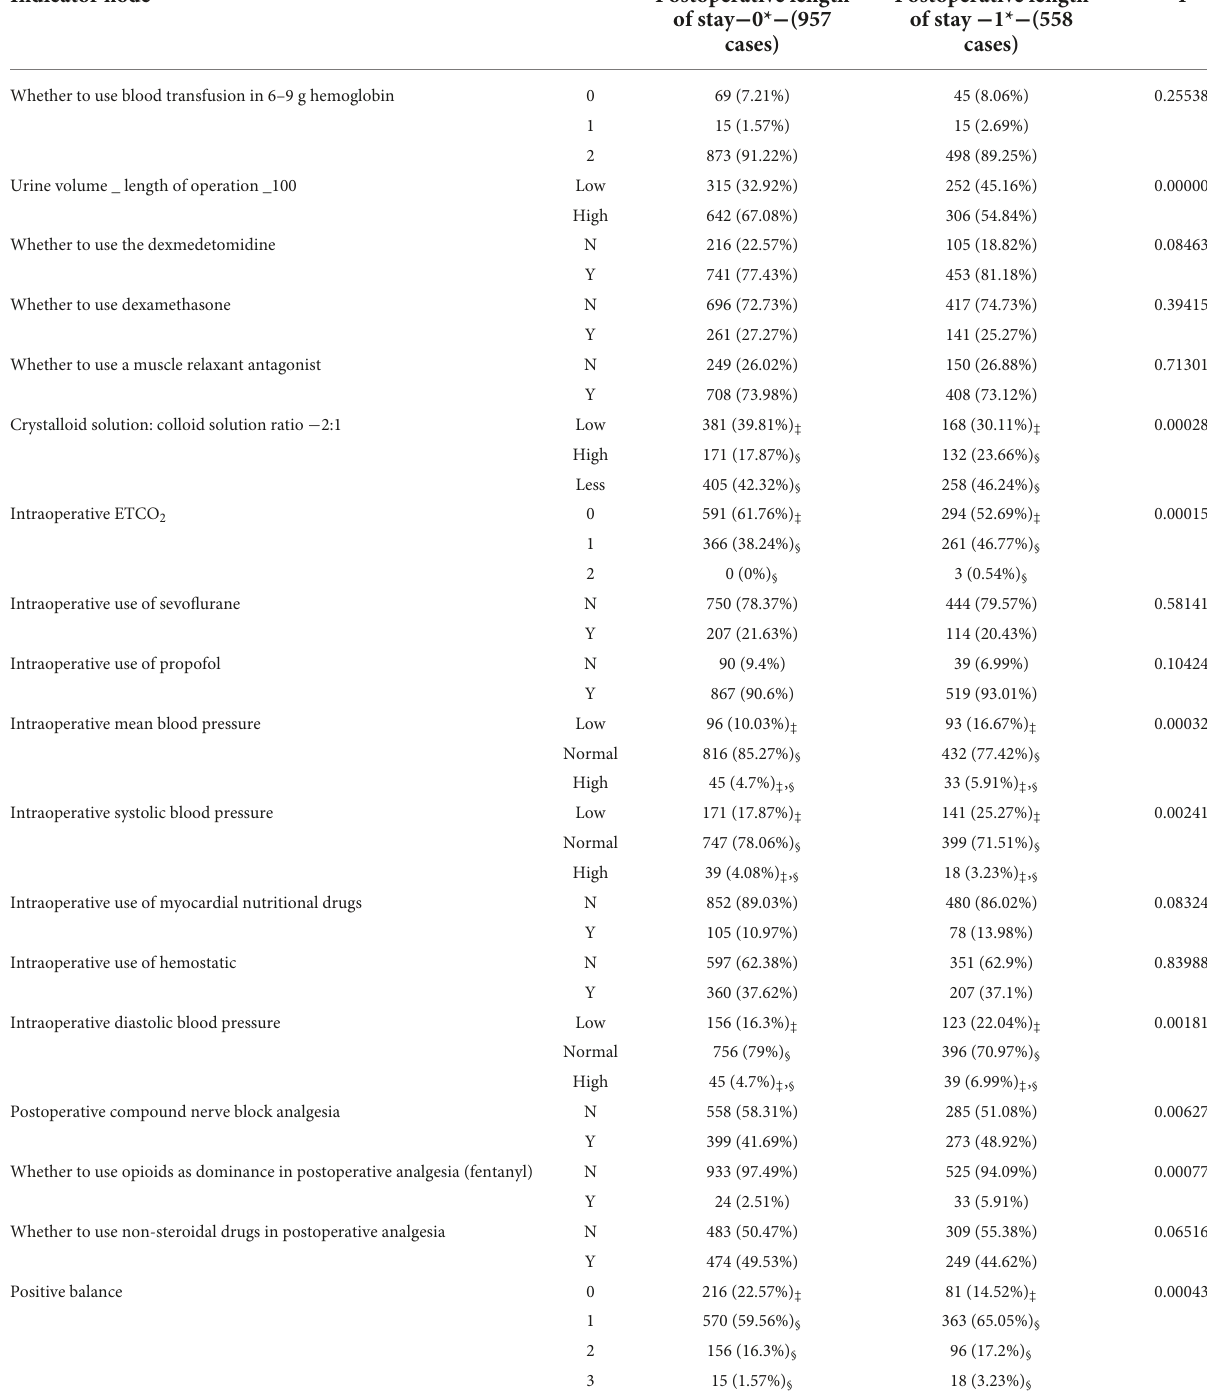
TABLE 3 The influence of Bayesian indicator nodes for the postoperative length of stay. Indicator